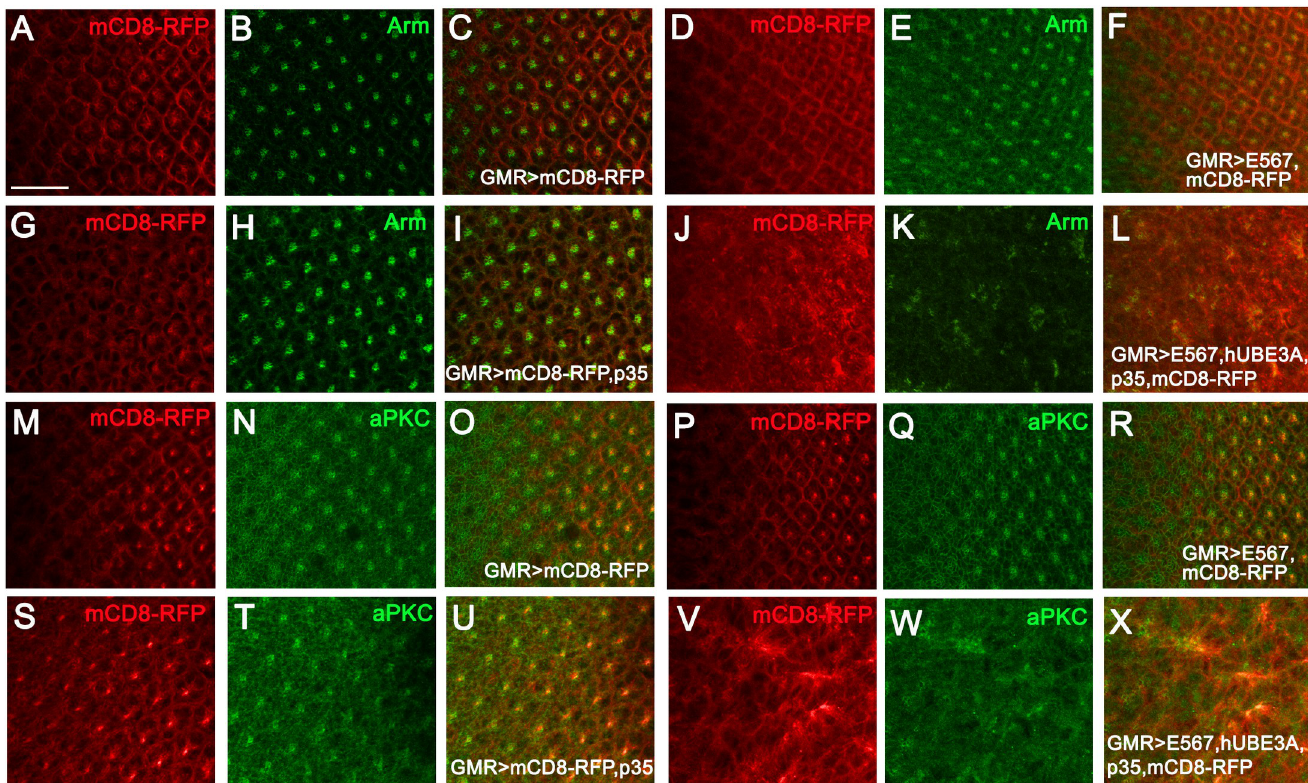
Fig 5. HPV16 E5, E6, and E7 oncoproteins disrupt cellular polarity. Transgenes were expressed using GMR-Gal4 in the third instar larval eye discs. mCD8RFP was used to mark the transgenes expression region and tissues were immunolabeled for polarity proteins, Arm and aPKC. (A-C) Eye disc expressing mCD8RFP exhibited an intact epithelium with a sequential pattern of ommatidia (A) and proper localization of Arm (B) . (D-F) Eye disc co-expressing E5, E6, E7+ mCD8RFP exhibited a similar result to control eye in A-C. (G-I) Eye disc co-expressing mCD8RFP+p35 showed an intact epithelium (G) with proper Arm localization (H) and ommatidia pattern to those in A-C and D-F. (J-L) Co-expression of E5, E6, E7+hUBE3A+ mCD8RFP +p35 resulted in impaired cell differentiation as no ommatidia had formed (J) and epithelial cell polarity was perturbed as Arm was either mislocalized or absent (K) . (M-O) Eye disc expressing mCD8RFP exhibited an intact epithelium with a sequential pattern of ommatidia (M) and proper localization of aPKC (N) . (P-R) Eye disc co-expressing E5, E6, E7+ mCD8RFP exhibited a similar result to control eye in M-O. (S-U) Eye disc co-expressing mCD8RFP+p35 showed an intact epithelium (S) with proper aPKC localization (T) and ommatidia pattern to those in M-O and P-R. (V-X) Co-expression of E5, E6, E7+hUBE3A+ mCD8RFP +p35 resulted in impaired cell differentiation as no ommatidia had formed (V) and epithelial cell polarity was perturbed as aPKC was absent (W) . Scale bar represents 100 μ m.